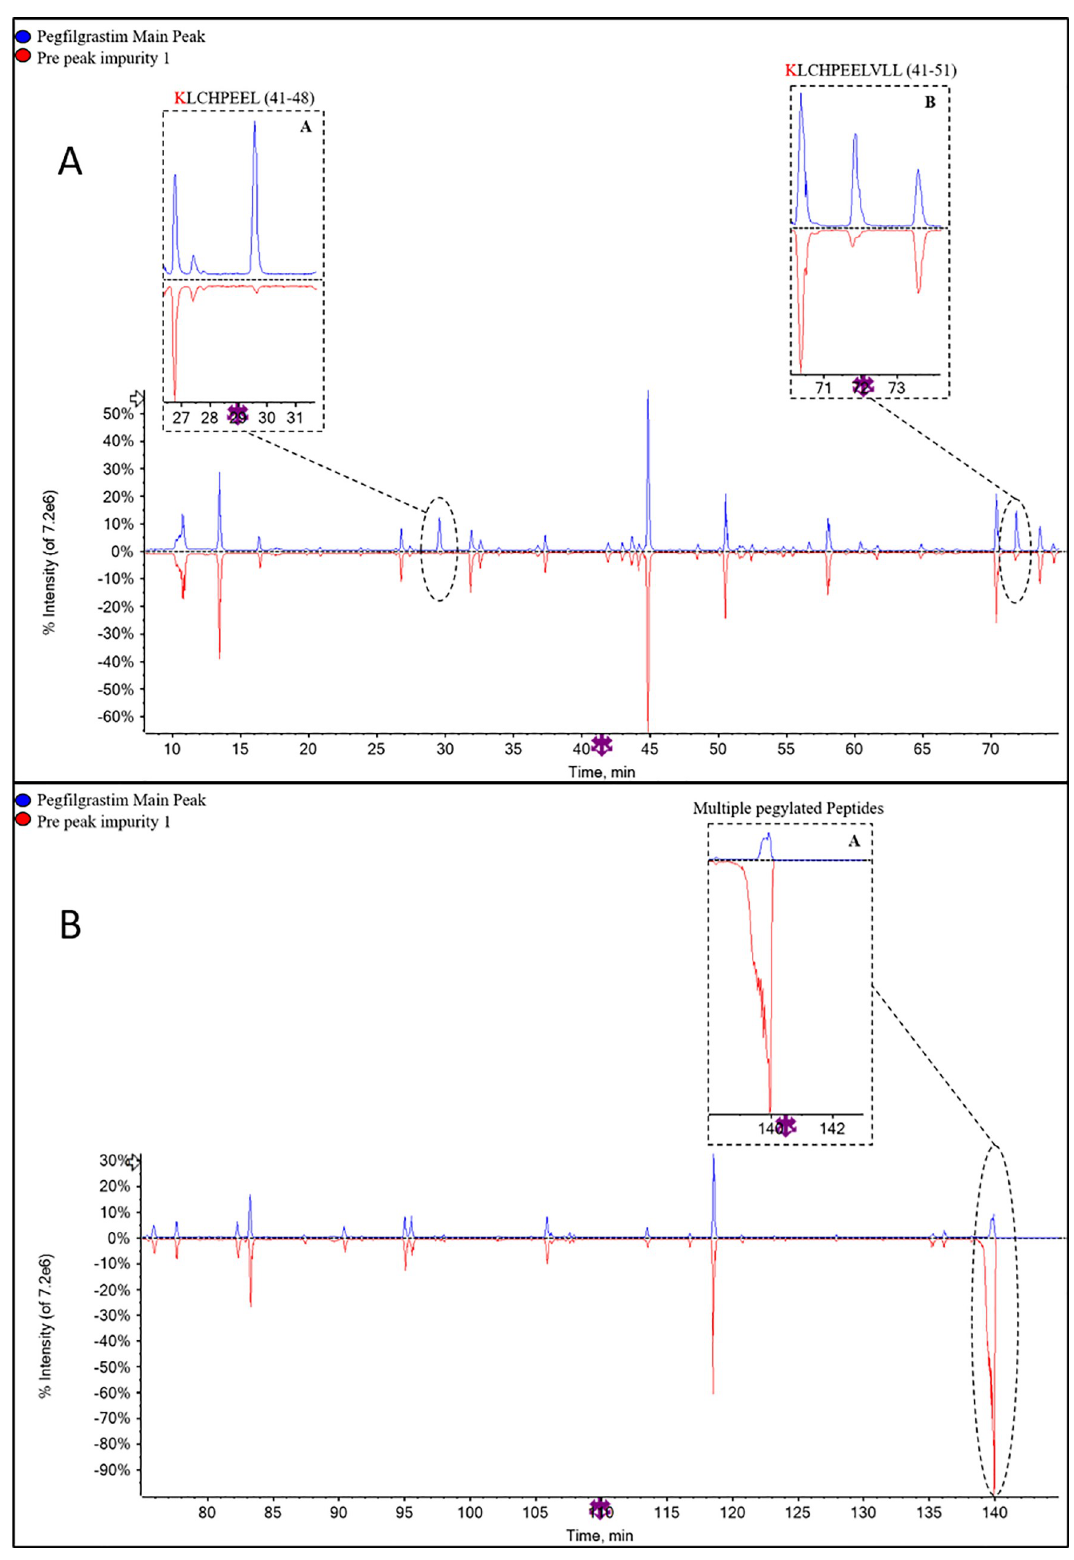
Fig 10. (A) TIC overlay of pegfilgrastim main peak and Pre-peak impurity 1 (RRT 0.60) in peptide mapping (10–75 min) (B) TIC overlay of pegfilgrastim main peak and Pre-peak impurity 1 (RRT- 0.60), TIC of peptide mapping (75–145 min). https://doi.org/10.1371/journal.pone.0212622.g010 PLOS ONE | https://doi.org/10.1371/journal.pone.0212622 March 13,